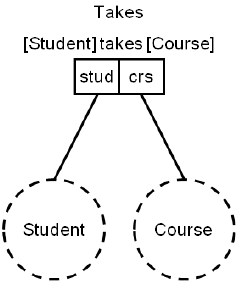
Figure 7. Students taking